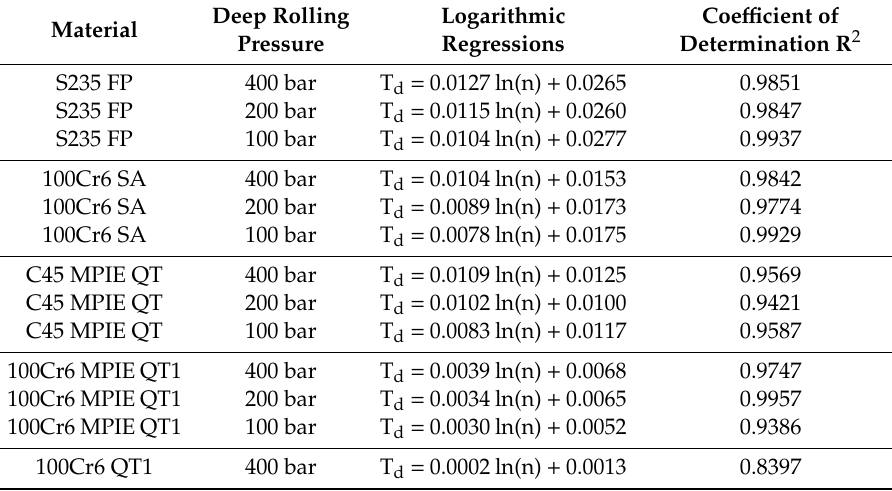
Table 6. Logarithmic regressions for n ≥ 1 of the specific track depths in Figure 5.